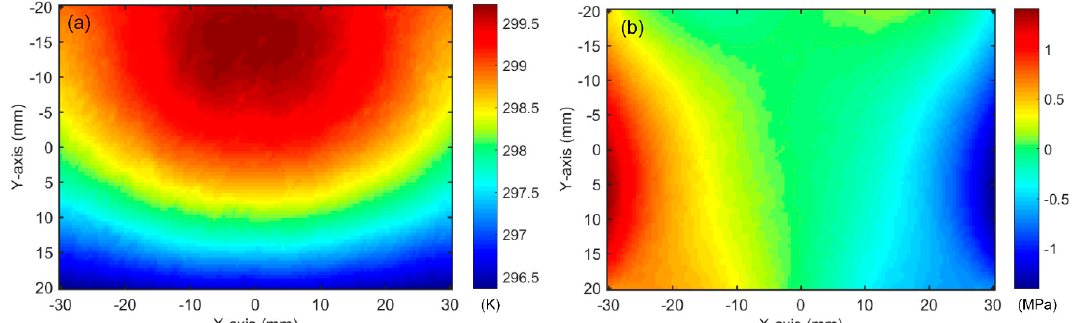
Figure 8. ( a ) Temperature distribution in central plane; ( b ) stress distribution in central plane.